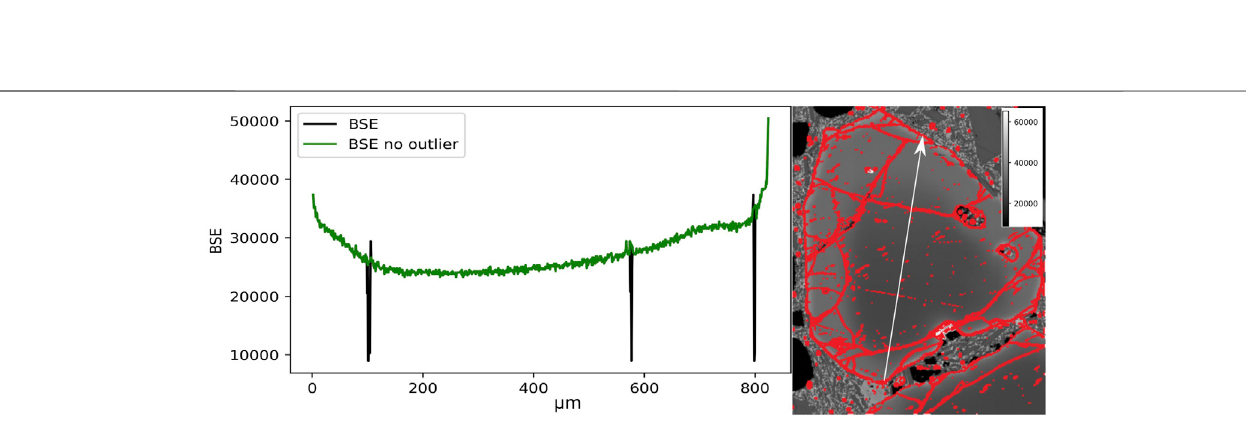
Frontiers in Earth Science |